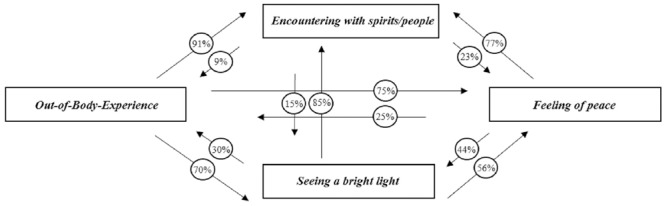
Frequency of 2 NDE features sequences in order of occurrence reported in narratives (values in parentheses are percentages calculated out of the total amount of narratives containing both NDE features).